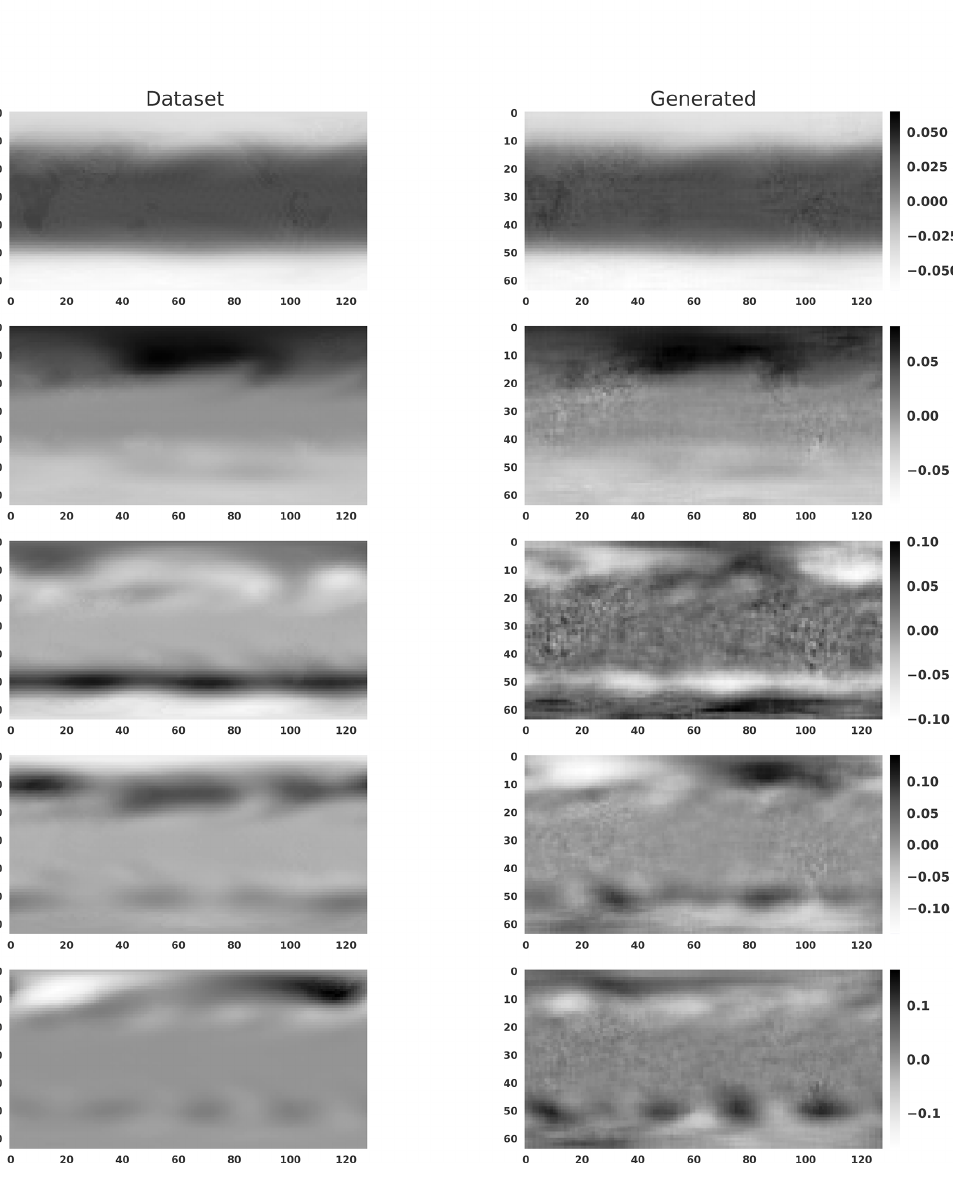
Figure 13. Spatial components corresponding to principal components of SVDs applied to the dataset and the generated